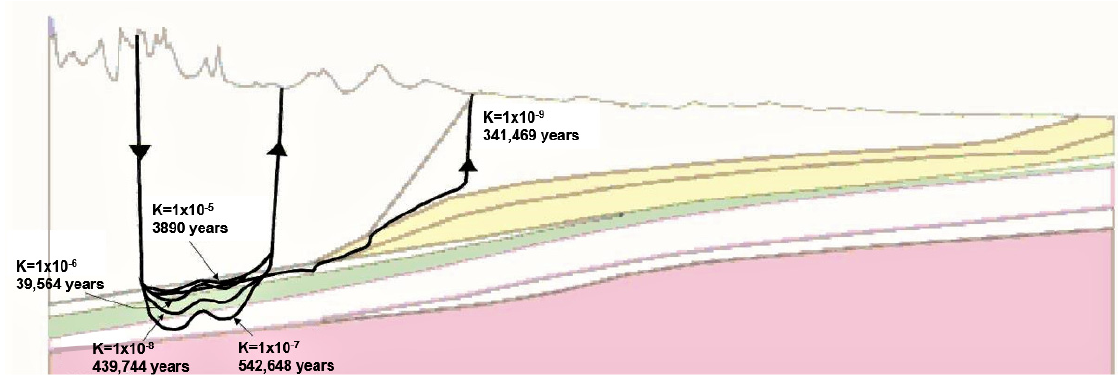
Figure 15. Sensitivity analysis results for the Mountainous terrain.